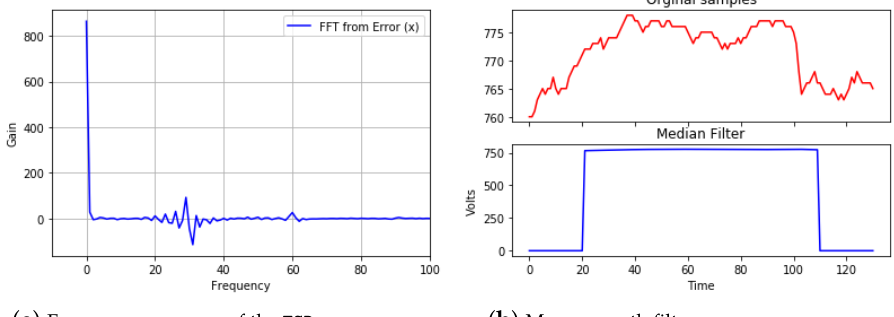
Figure 3. Testing results of the sensor’s filtered